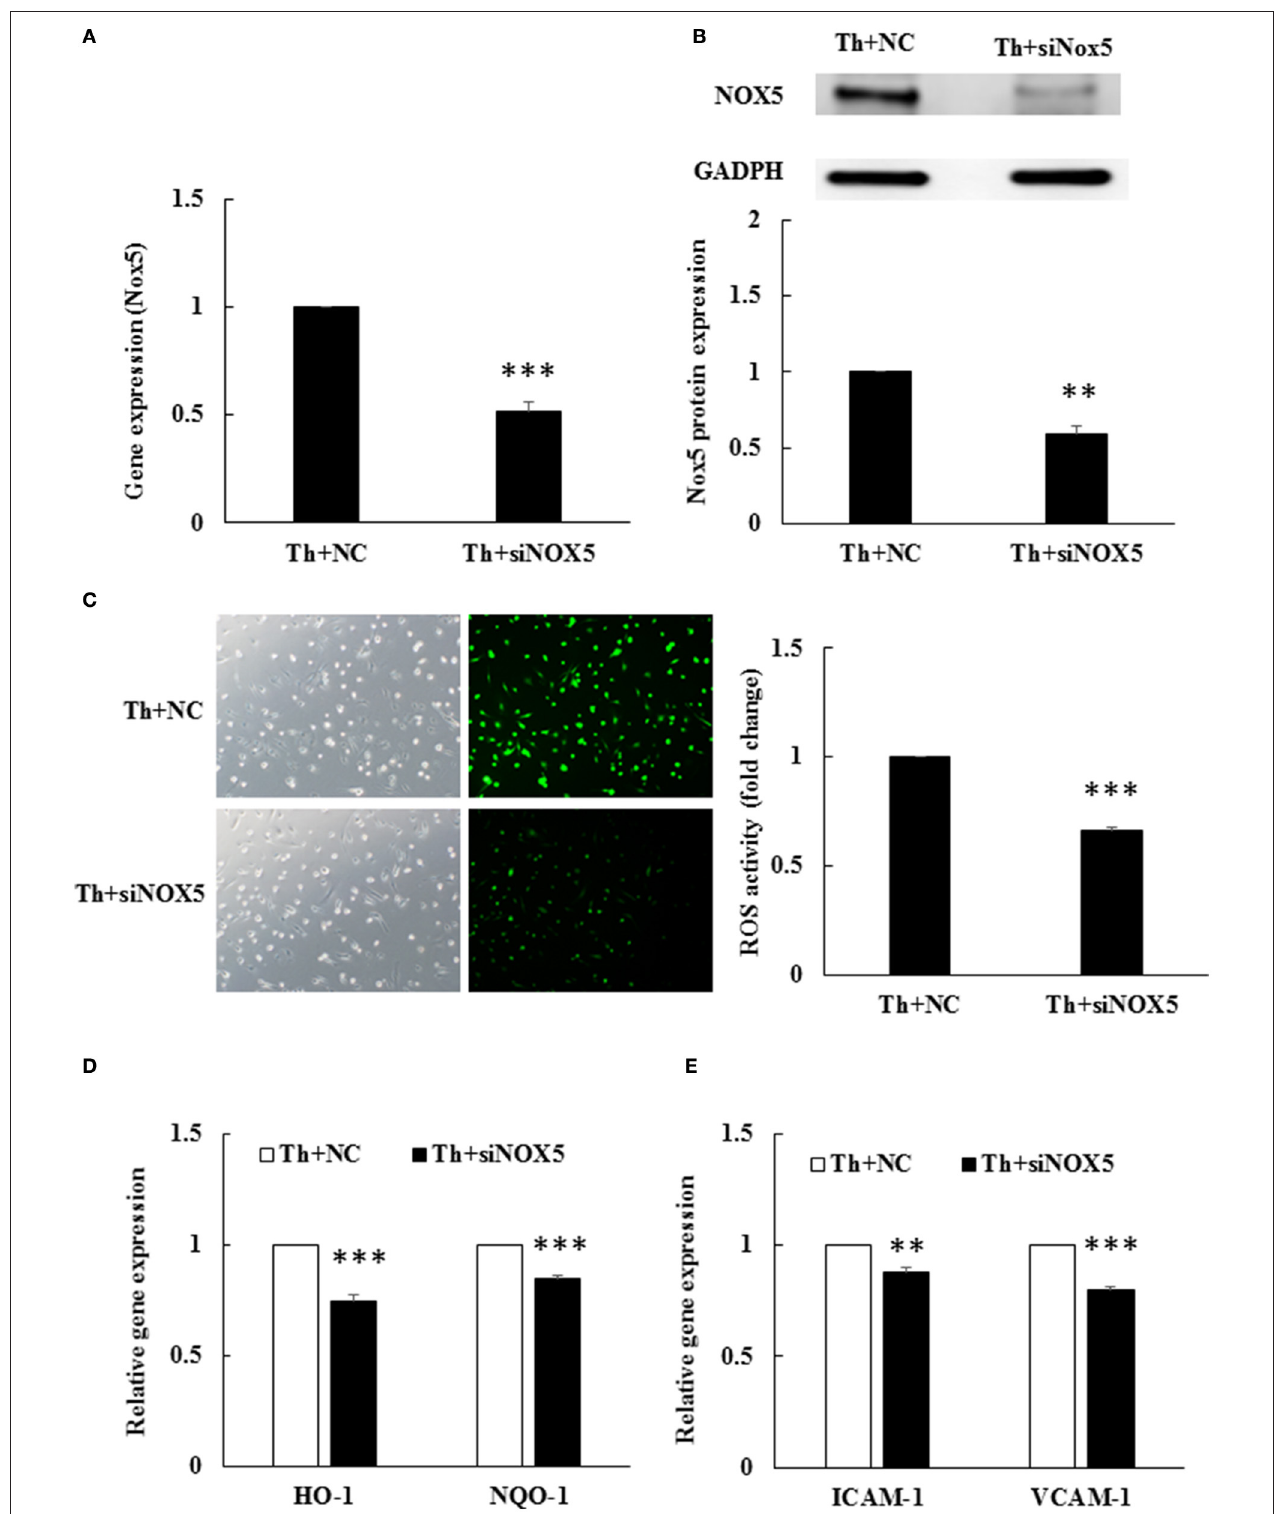
FIGURE 3 | Thrombin-induced ROS production depends on Nox5. HAECs were stimulated with thrombin (2 U/mL) for 5h with or without 100nM angiotensin-(1-7) pretreatment 1h before the thrombin stimulation. (A) Nox5 siRNA transfection caused a significant decrease in Nox5 mRNA expression in